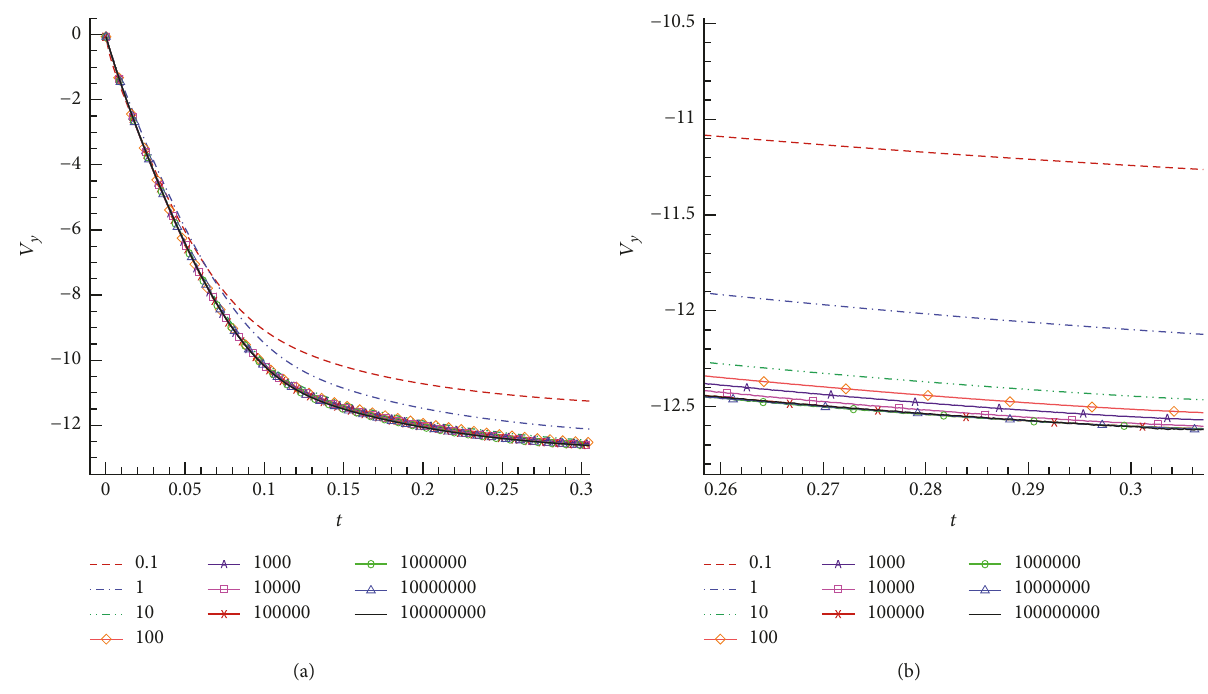
Figure 3: Sensitivity of the cylinder falling velocity to 𝜆